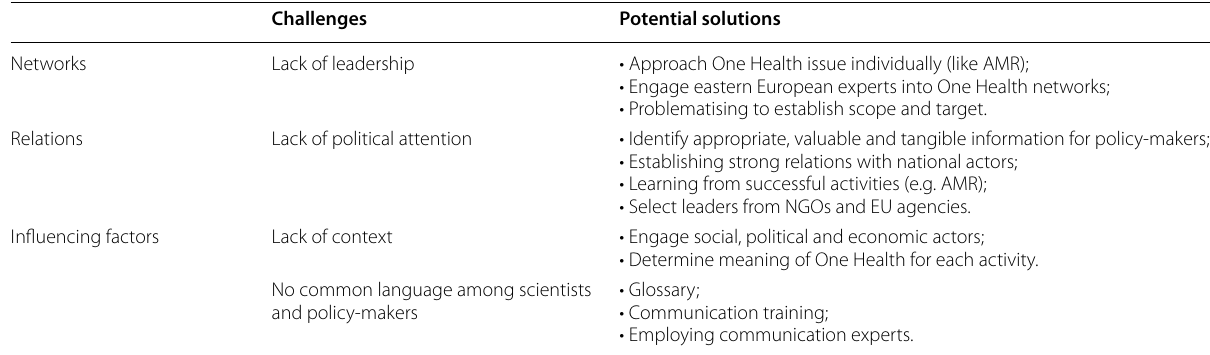
Table 5 Dimensions of the knowledge translation process, challenges and potential